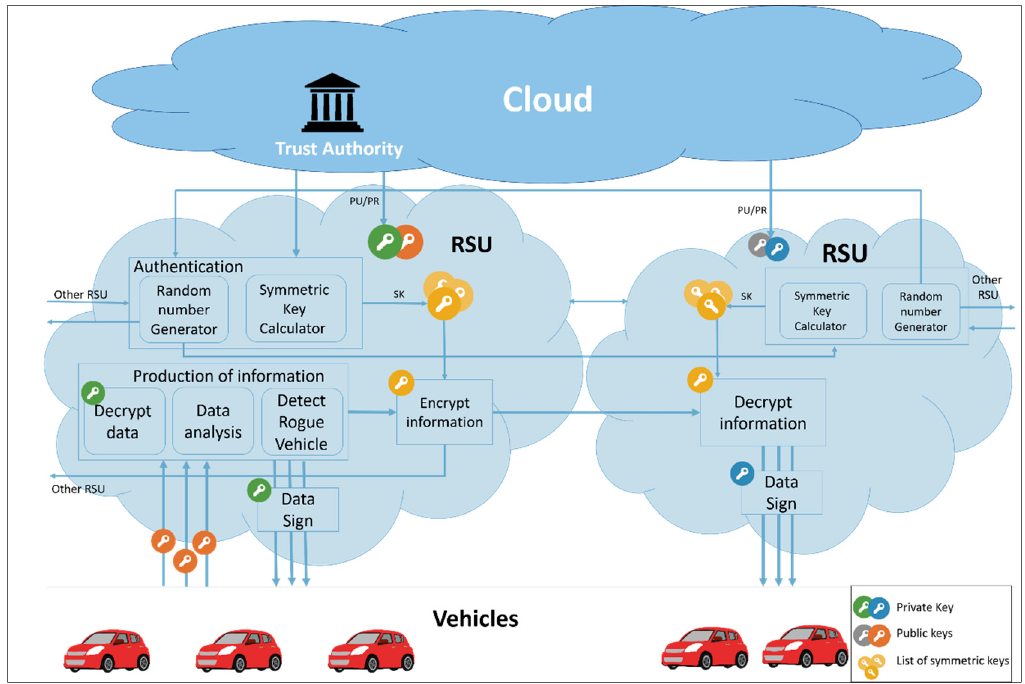
Figure 2. The system model of privacy-preserving vehicular rogue node detection scheme using fog computing.